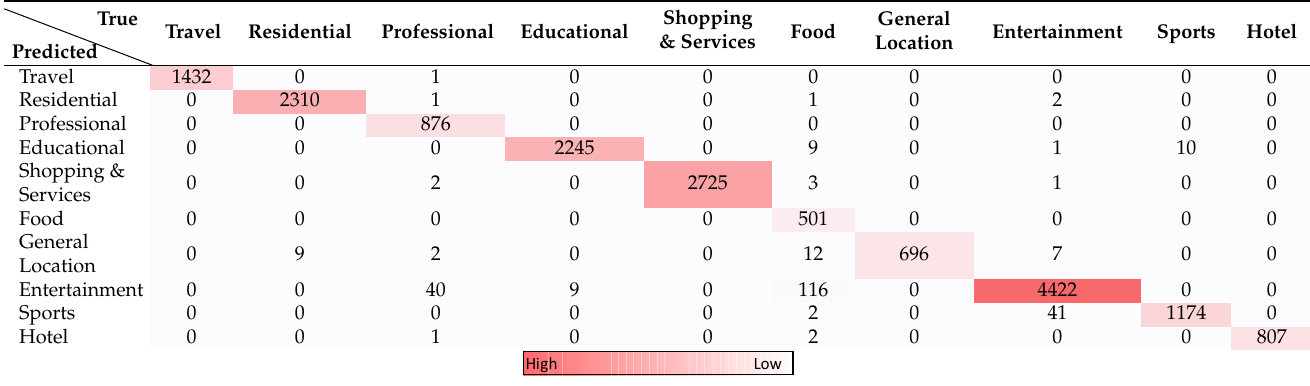
Table 4. Confusion Matrix for Deep-Learning Model. Table 6. Confusion Matrix for Gradient-Boosted Trees Model.